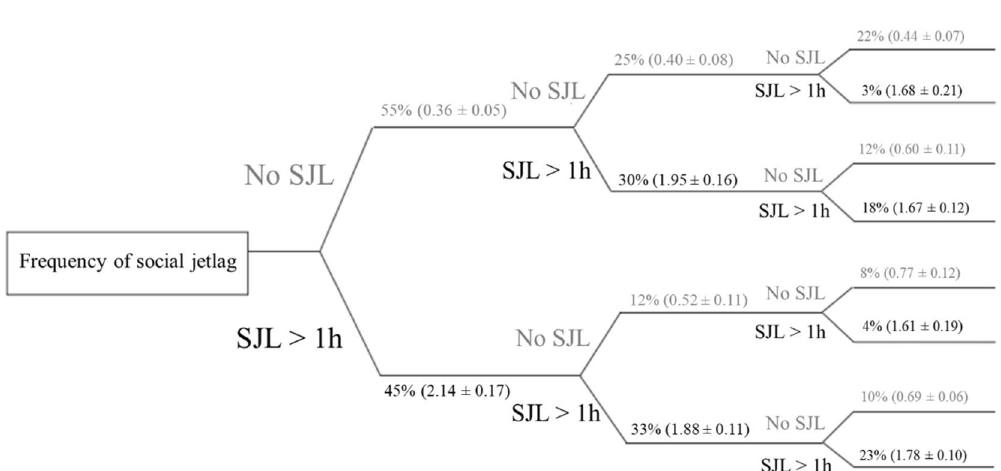
Figure 4. Trajectory of social jetlag (SJL) (No ≤ 1 h or > 1 h) category across three trimesters in the pregnant women in the longitudinal phase (n = 100). The categories were summarized using frequencies (%). Means ± standard error (SE) of each category are presented in